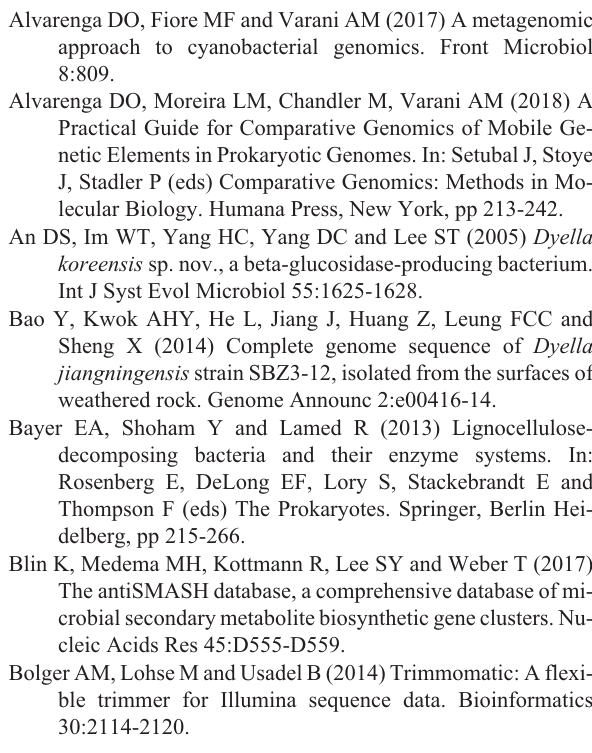
Table S1 - Publicly-available Dyella genomes used in this study for comparative